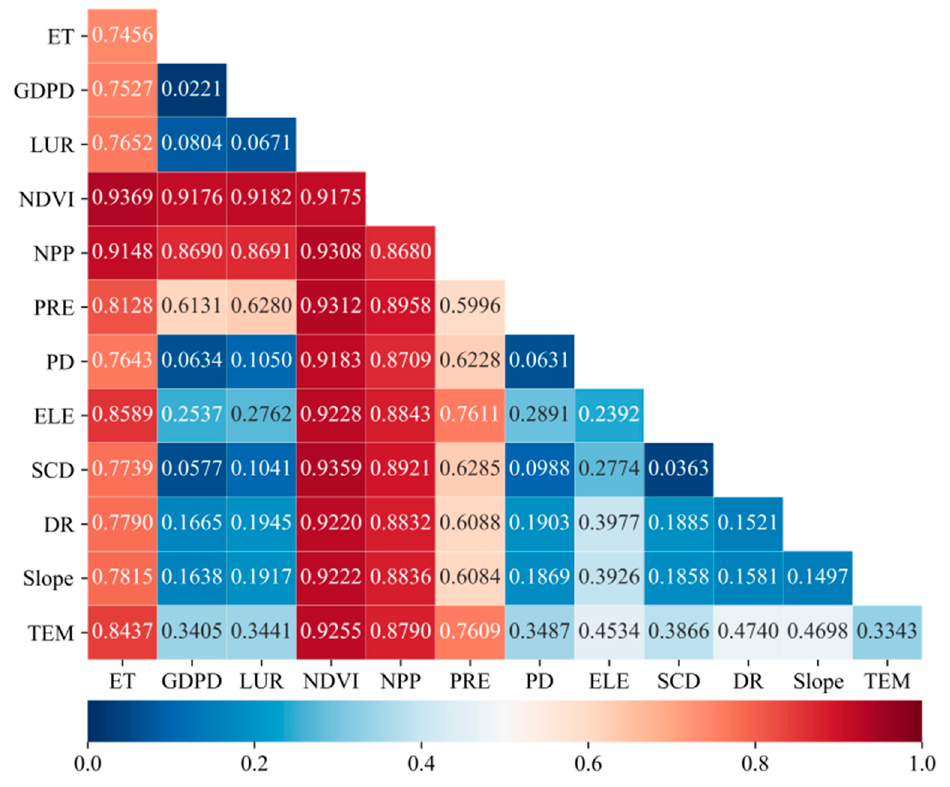
Figure 9. Interactions between pairs of forces influencing EVI. (Notes: the q -statistic on the diagonal line in each case denotes the separate effects of each variable (Table 2), whereas the lower periodic matrix includes values for interactive effects between private sources.).